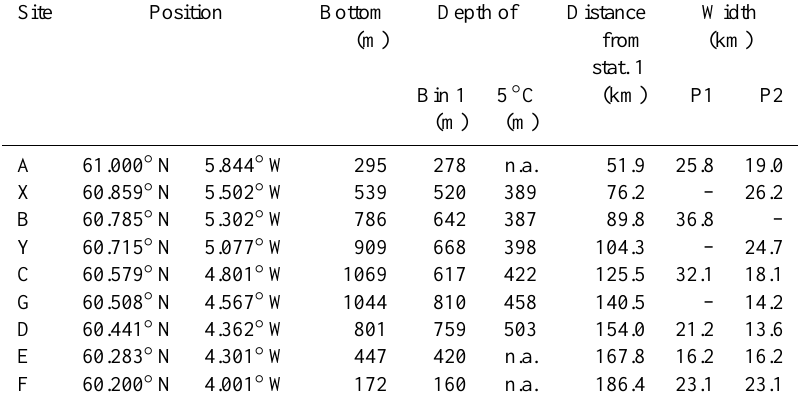
Table 1. Metadata of ADCP moorings sites: site name, position, bottom depth, depth of the deepest bin (bin 1) measured by the ADCP, average depth of the 5 ◦ C isotherm, distance from CTD station 1, and representative width used in Eq. (2). Two columns of width are reported due to the mooring array comprising either 4 (P1) or 7 (P2) sites; see text for details (n.a. indicates the entire water column is warmer than 5 ◦ C; P1=Period 1=Nov. 1994–May 2009; P2=Period 2=May 2009–May 2011). Site Position Bottom Depth of Distance Width (m) from (km) stat. 1 Bin 1 (km)